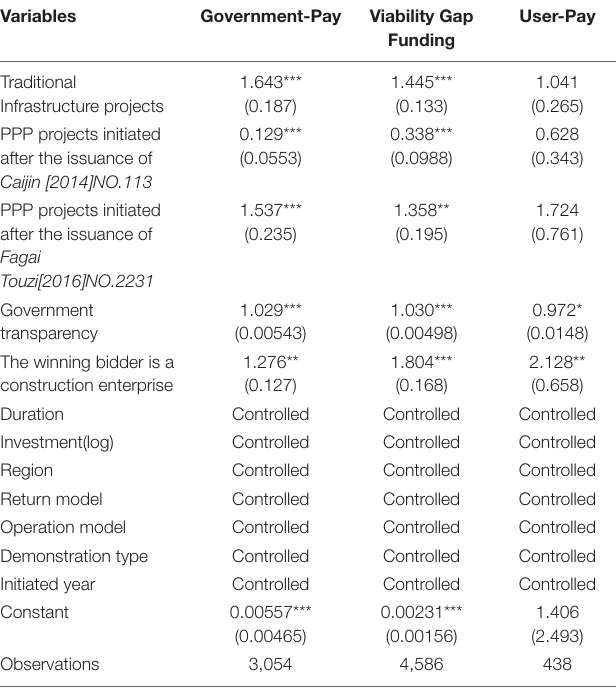
TABLE 9 | Regression result of heterogeneity analysis of return